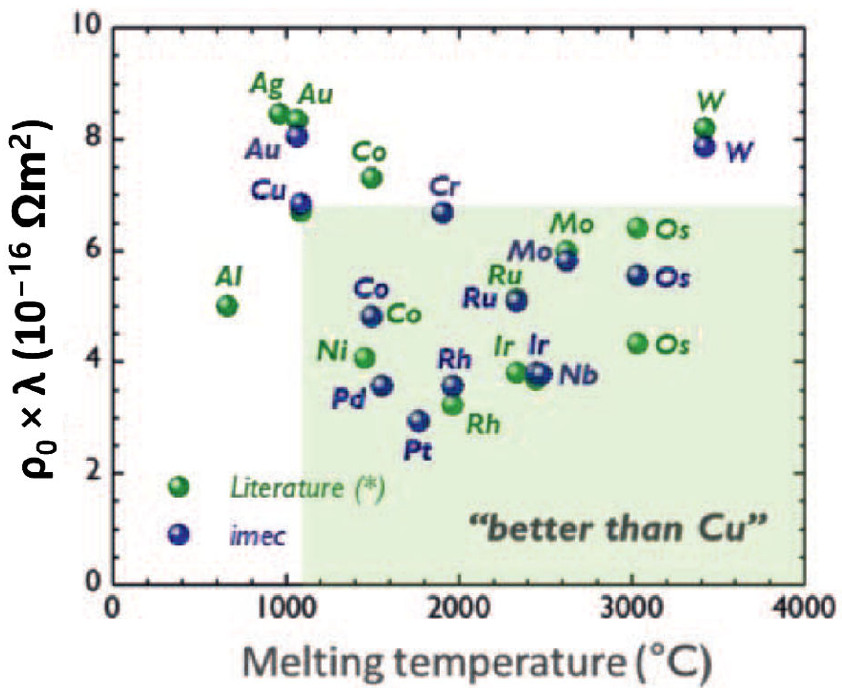
Figure 17. Figure of merit defined as mean free path ( λ ) × bulk resistivity ( ρ 0 ) vs. melting point for different metals. Reprinted/adjusted with permission from Ref. [81]. 2018,